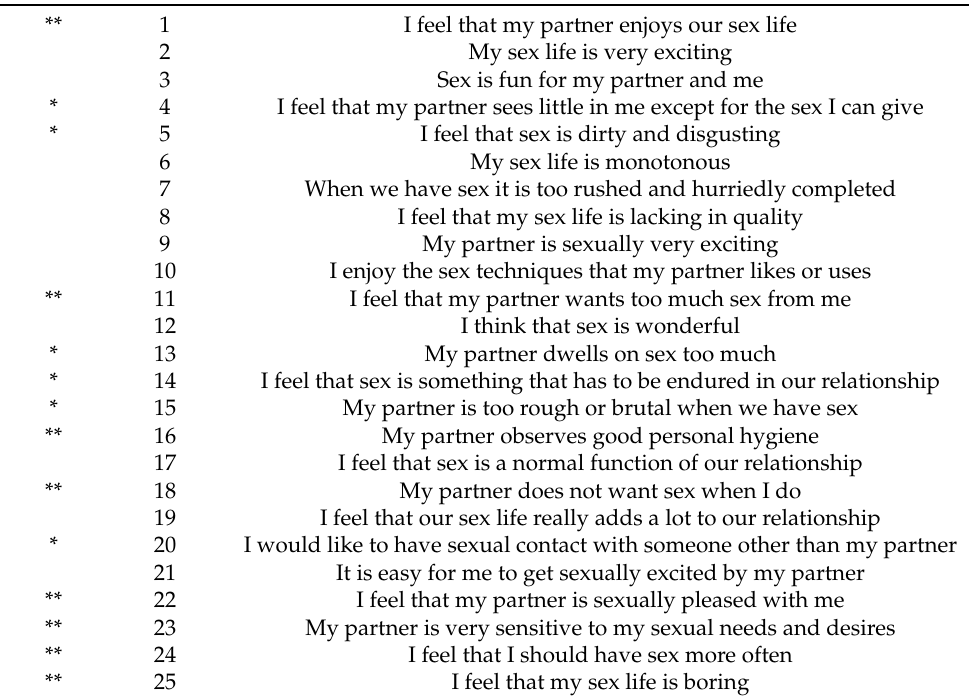
Table A1. Index of Sexual Satisfaction (Hudson et al.,